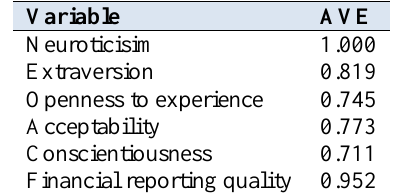
Table 4. AVE values for research model variables